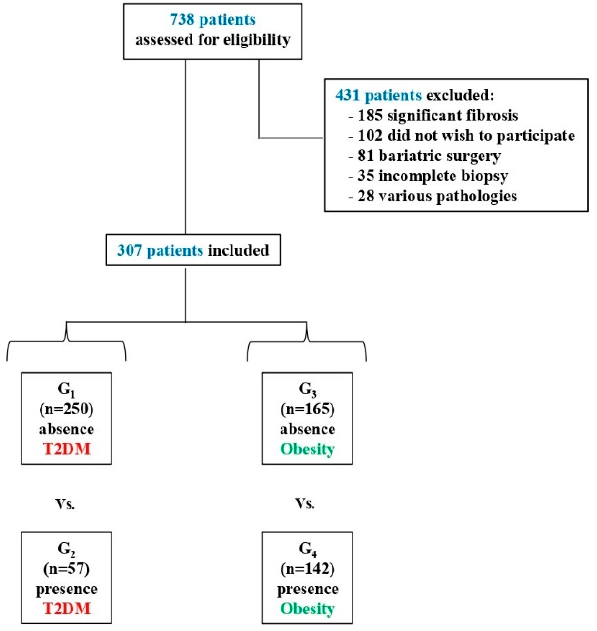
Figure 1. Participant selection for the study.